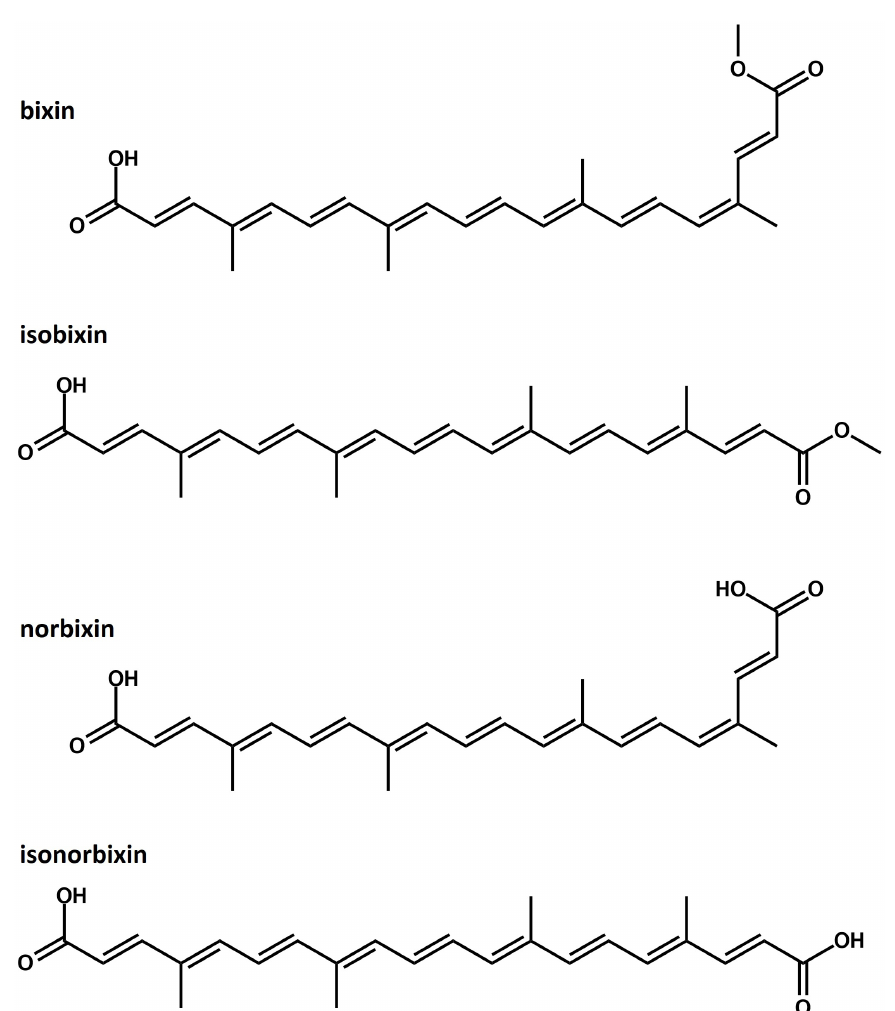
Figure 1. Schematic representation of the lattice structure of bixin, isobixin, norbixin, and